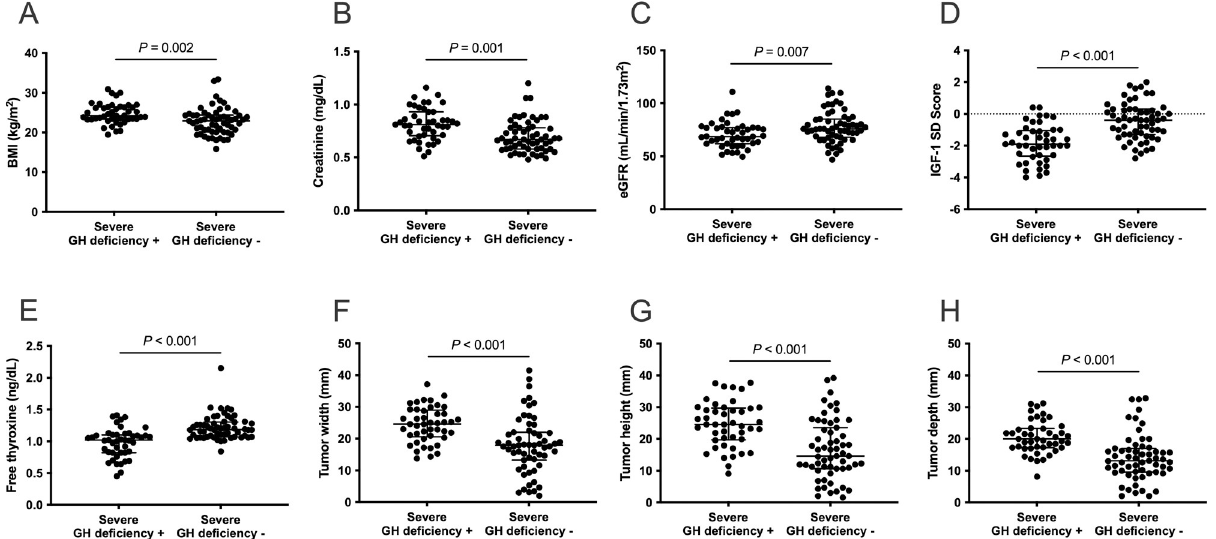
Fig 1. Background characteristics and severe GH deficiency (GHD). (A) BMI, (B) serum creatinine level, (F) tumor width, (G) height, and (H) depth are significantly higher in patients with severe GHD than in those without severe GHD. (C) Estimated GFR, (D) IGF-1 SD score, and (E) free thyroxine levels were significantly lower in patients with severe GHD than in those without severe GHD. GH, growth hormone; BMI, body mass index; GFR, glomerular filtration rate.